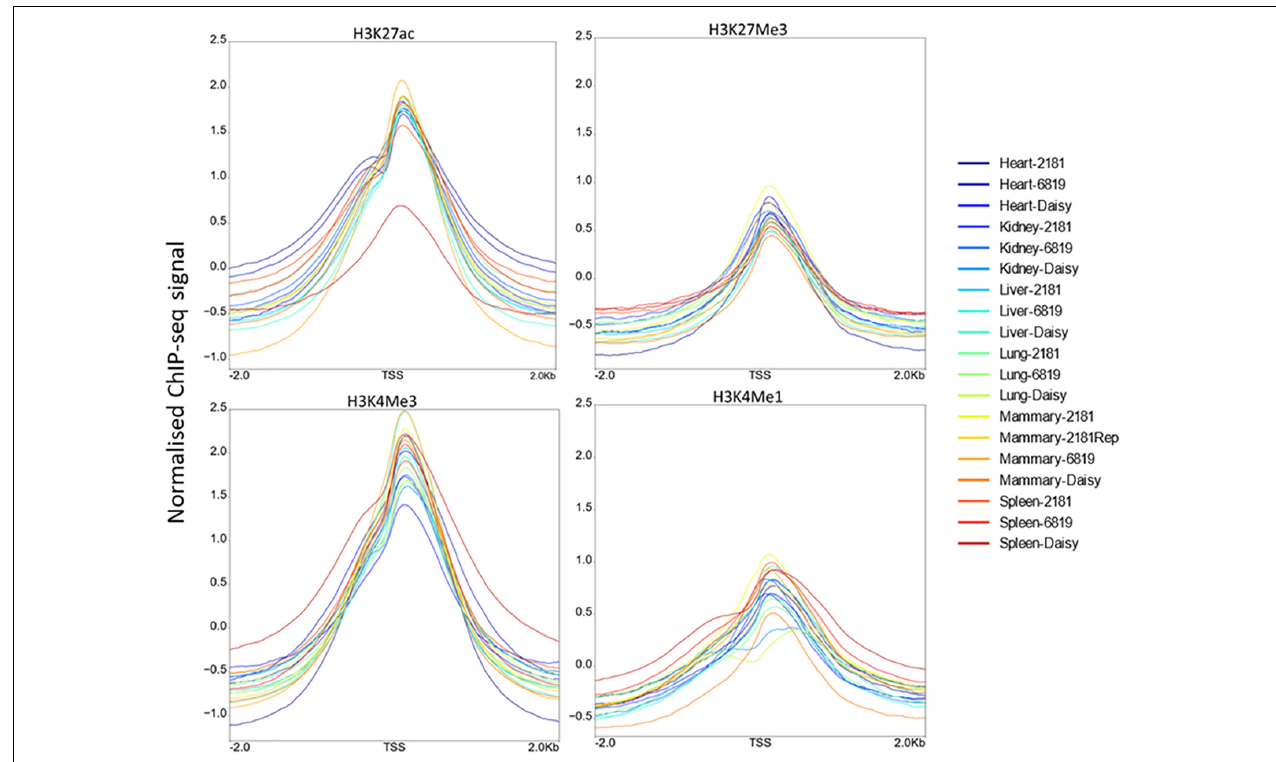
FIGURE 2 | Distribution of ChIP-seq reads around the transcription start site (TSS). For each histone modification these plots show the normalised ChIP-seq signal above input signal within 2 kb of the TSS.